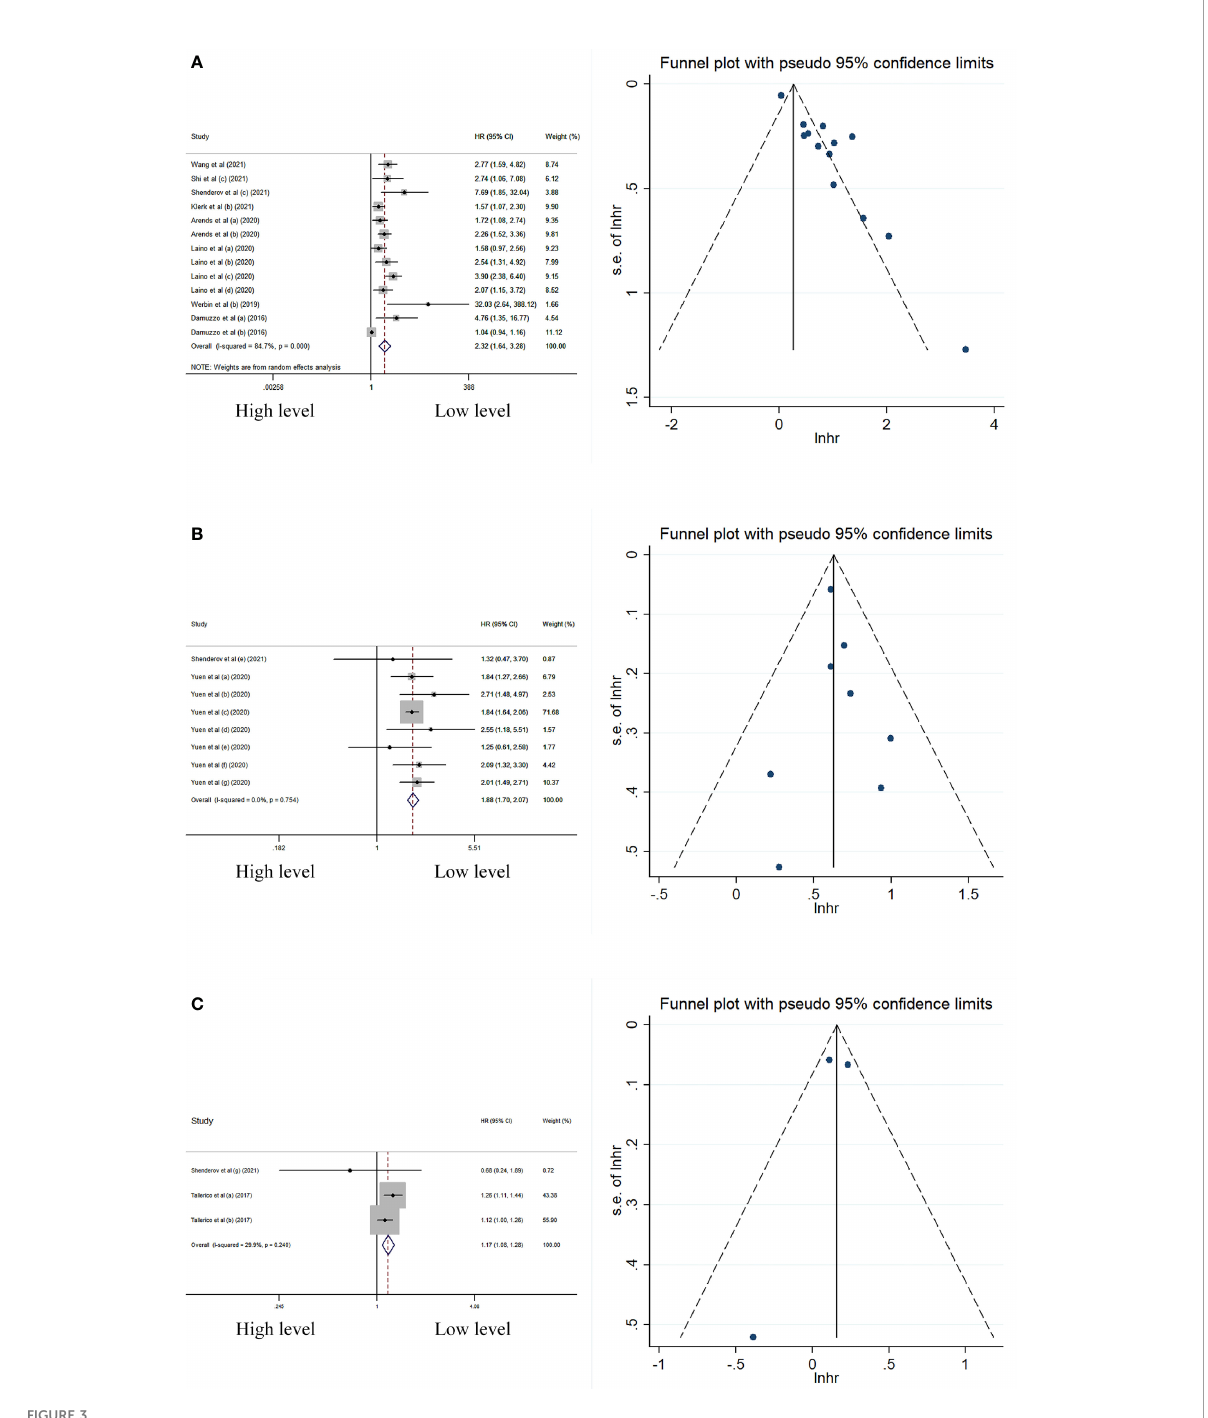
FIGURE 3 Forest plot and funnel plot of studies investigating levels of peripheral (A) IL-6, (B) IL-8, and (C) IL-15 in multivariable analysis of